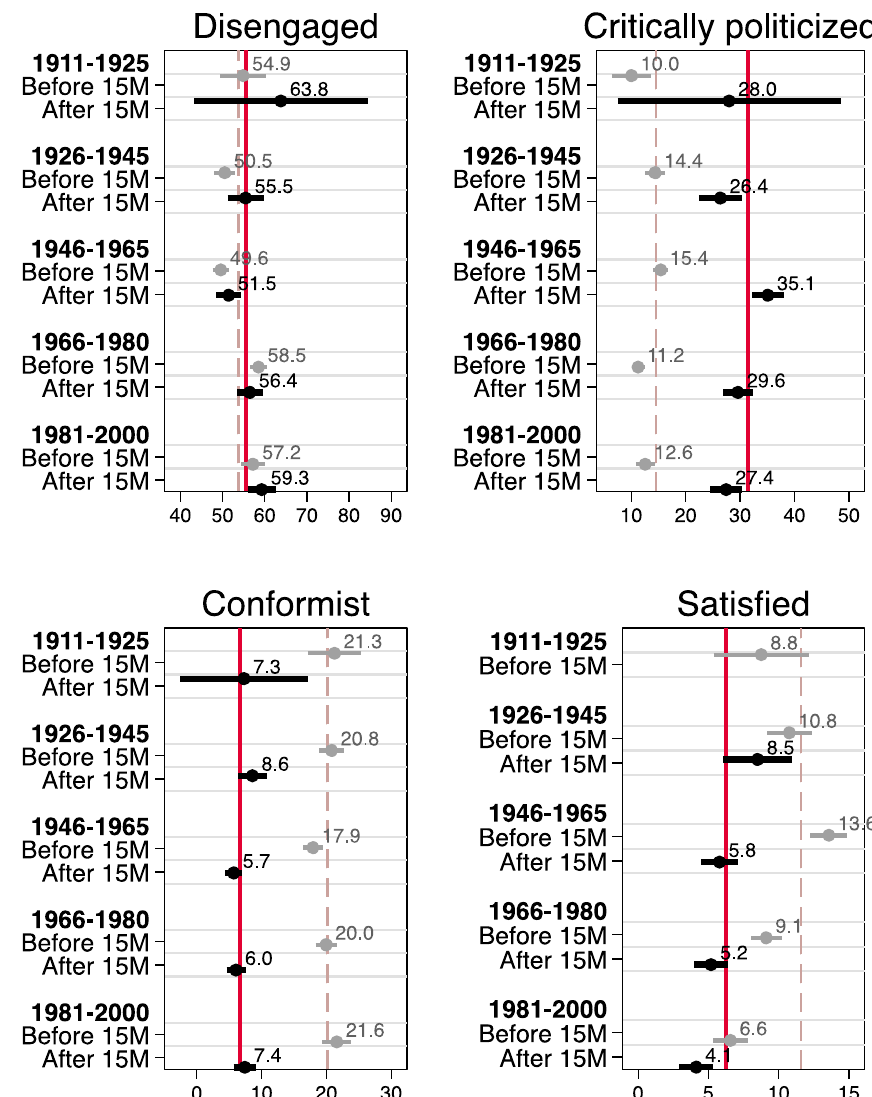
Figure 8. Predicted probabilities of attitudes towards politics by birth cohorts and political cycle. Birth cohorts: 1911–1925 (greatest generation), 1926–1945 (silent generation), 1946–1965 (baby boomers), 1966–1980 (generation X), and 1981–2000 (millennials) See Note 5. Binominal logistic models estimated separately with interaction between age and political cycle. Vertical lines represent average values before (clear dashed line) and after 15-M (strong solid line). The ‘Before 15-M’ category includes ESS 1–4 (2002–2008) and ‘After 15-M’ refers to ESS 5–7 (2010–2014), whose fieldwork was conducted from the second quarter of 2011 onwards. Controls: gender, educational attainment, and economic difficulties in household. Weighted data. N = 13,314. Source: European Social Survey in Spain, rounds 1–7.